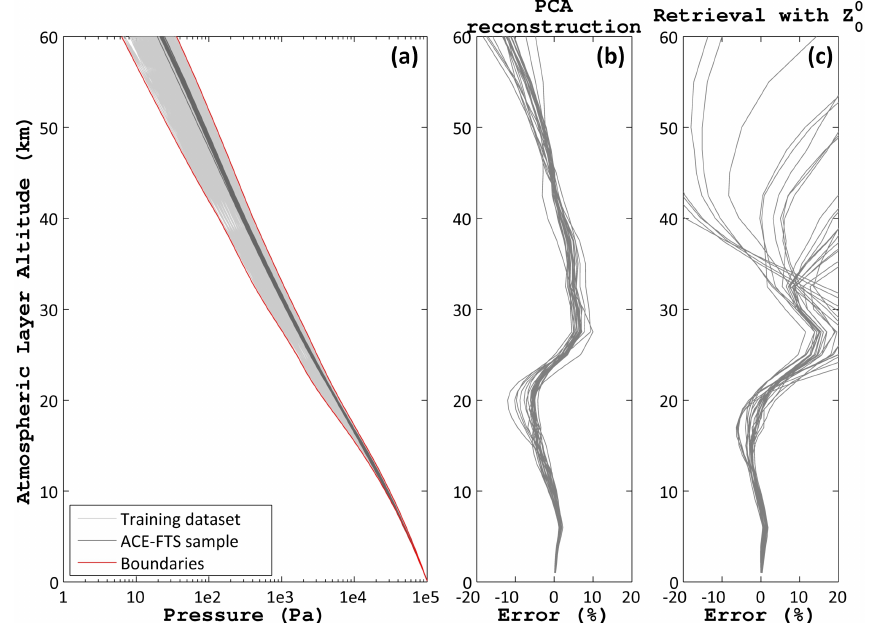
Fig. 8. First panel shows the ACE-FTS sample of 30 pressure profiles (dark gray) above the training dataset (pale gray). The red lines empha- size the boundaries of the training dataset. Second panel shows the relative difference between the original profiles and those reconstructed from a projection onto the principal axes of the training dataset. The third panel shows the relative difference between the original profiles and the retrieved ones using the first Zernike